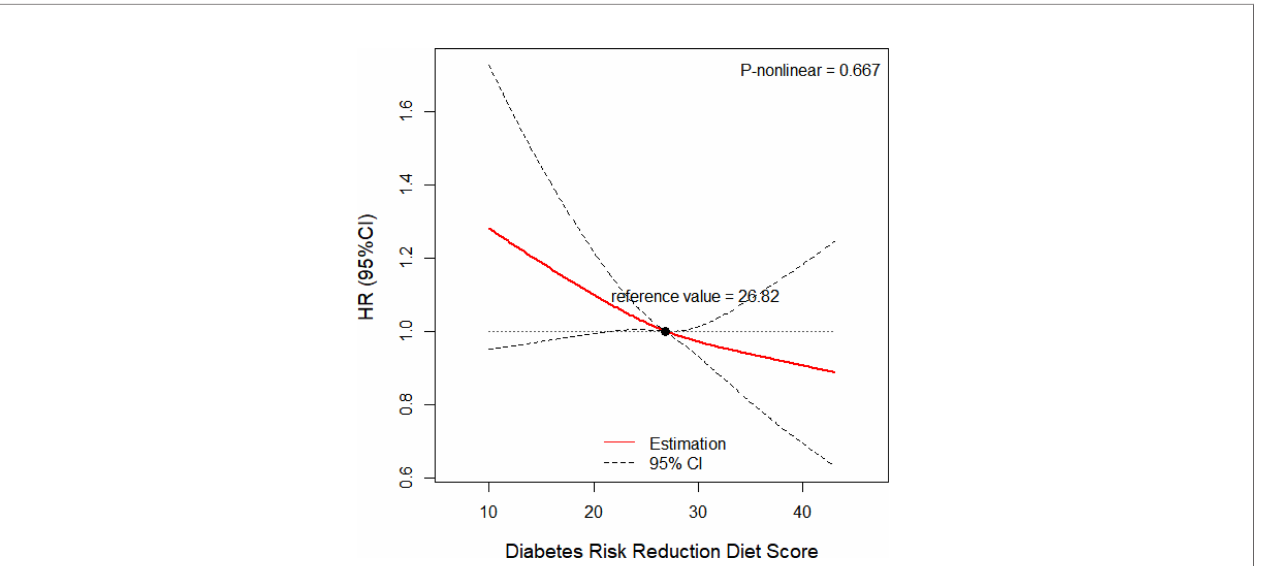
FIGURE 2 | Dose-response relationship between DRRD score and risk of lung cancer adjusted for age (continuous), sex (male or female), BMI (continuous), total energy intake (continuous), family history of lung cancer (yes, no, or possible), marital status (married or not married), race/ethnicity (white or non-white), smoking status (never, former smoker, current smoker), pack-years of cigarettes (continuous), alcohol intake (never, former, current, or unknown), history of diabetes (yes or no) (p for nonlinear= 0.667).